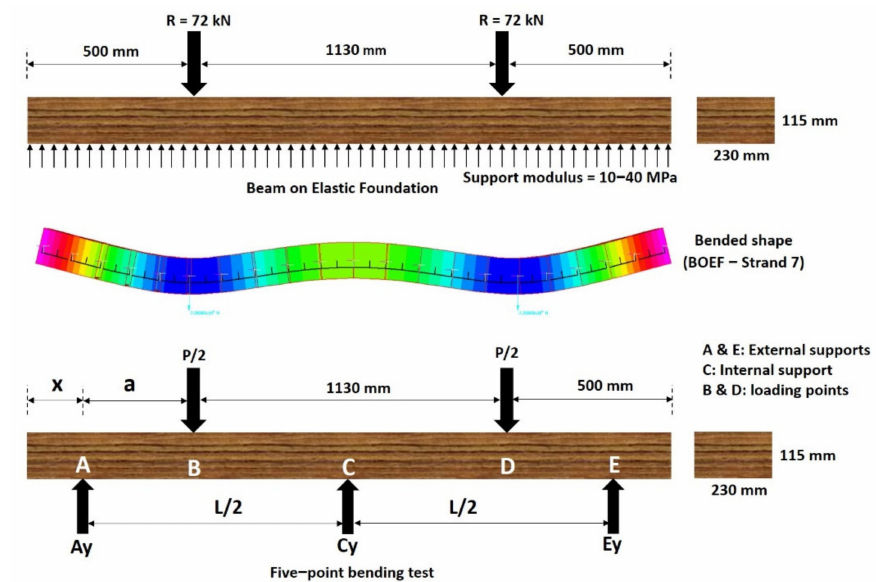
Figure 4. BOEF theory vs. five-point bending test.